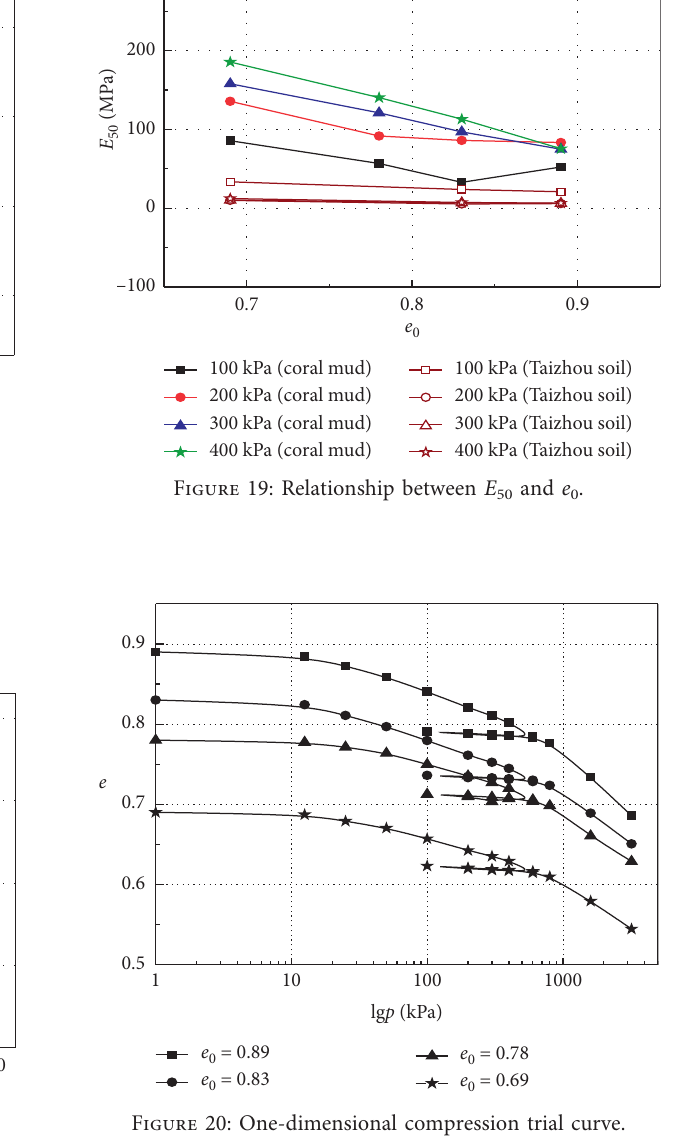
Figure 20: One-dimensional compression trial